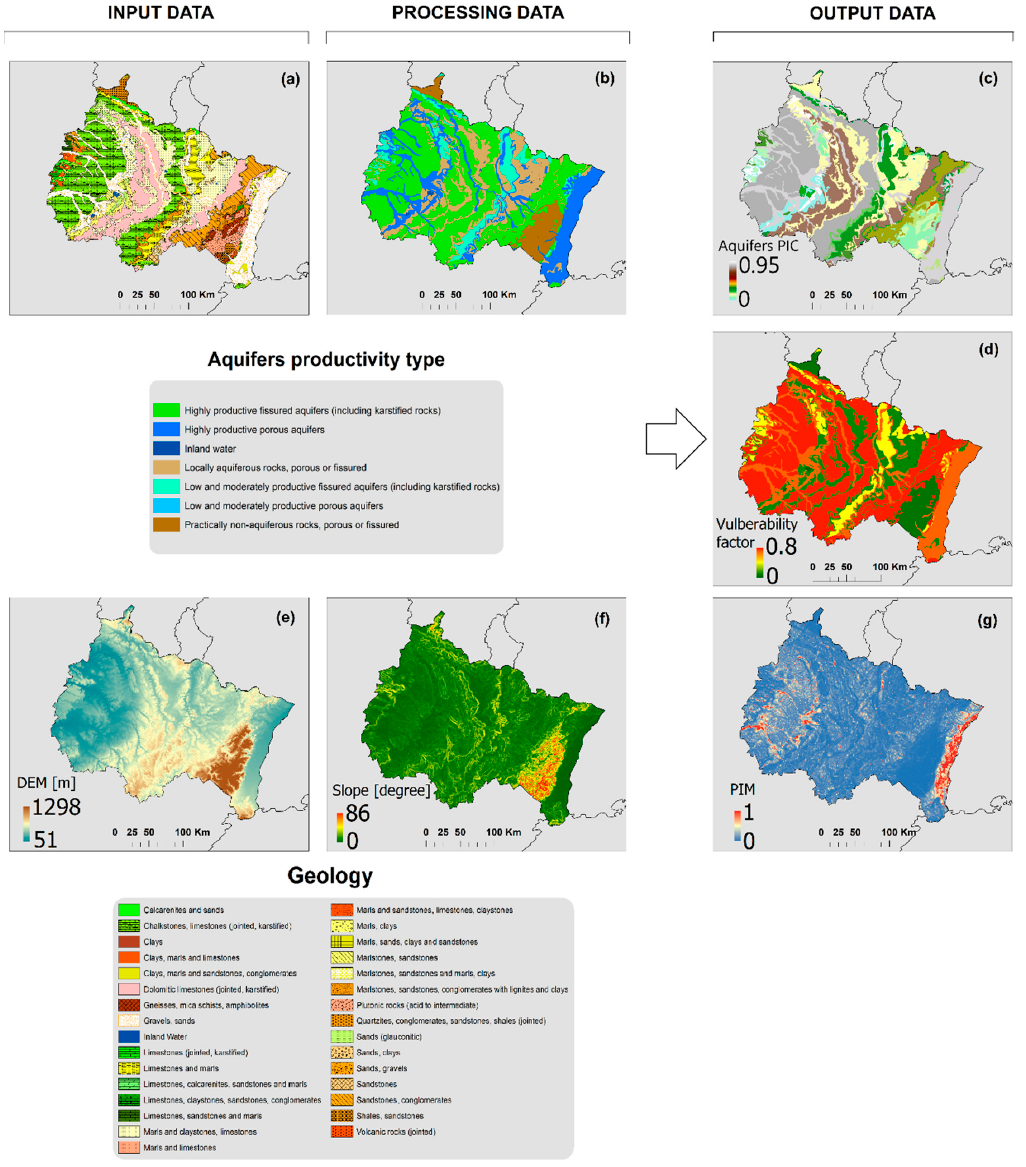
Figure 2. Grand framework of geological and terrain data, processing, and results from these layers the Grand Est region. ( a ) Geological formations map. ( b ) Aquifers productivity type map. ( c ) Potential infiltration coefficient (PIC) map. ( d ) Hydrogeological vulnerability factor (HVF) map. ( e ) Digital elevation model (DEM) map. ( f ) Slope angle map. ( g ) Potential infiltration map (PIM). Note: Potential infiltration map was calculated as the ratio of potential infiltration coefficient and normalization slope layer (radian degrees).